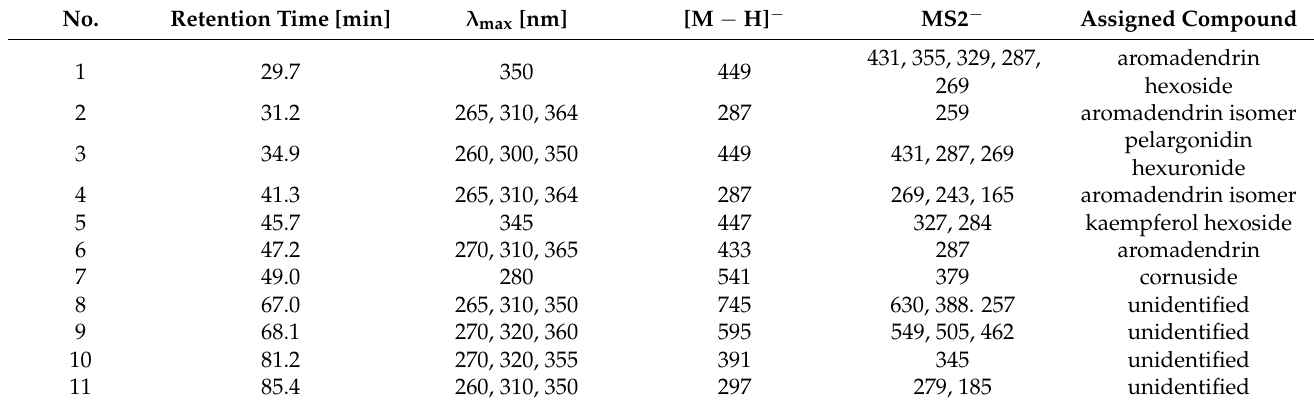
Table 2. MS spectrum data of compounds detected in fractions incubated with FS depending on